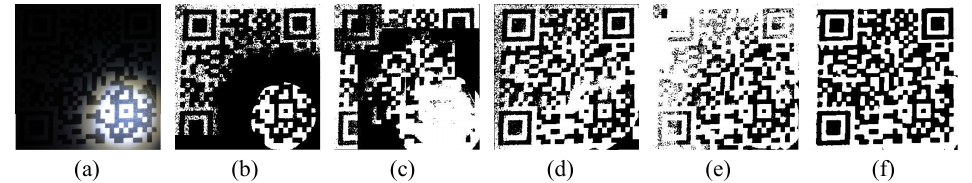
(f) Figure 17. The original image and experimental results of different algorithms: ( a ) Original image; ( b ) Sauvola’s algorithm; ( c ) Yao’s algorithm; ( d ) Di’s algorithm; ( e ) Chen’s algorithm; ( f ) Proposed